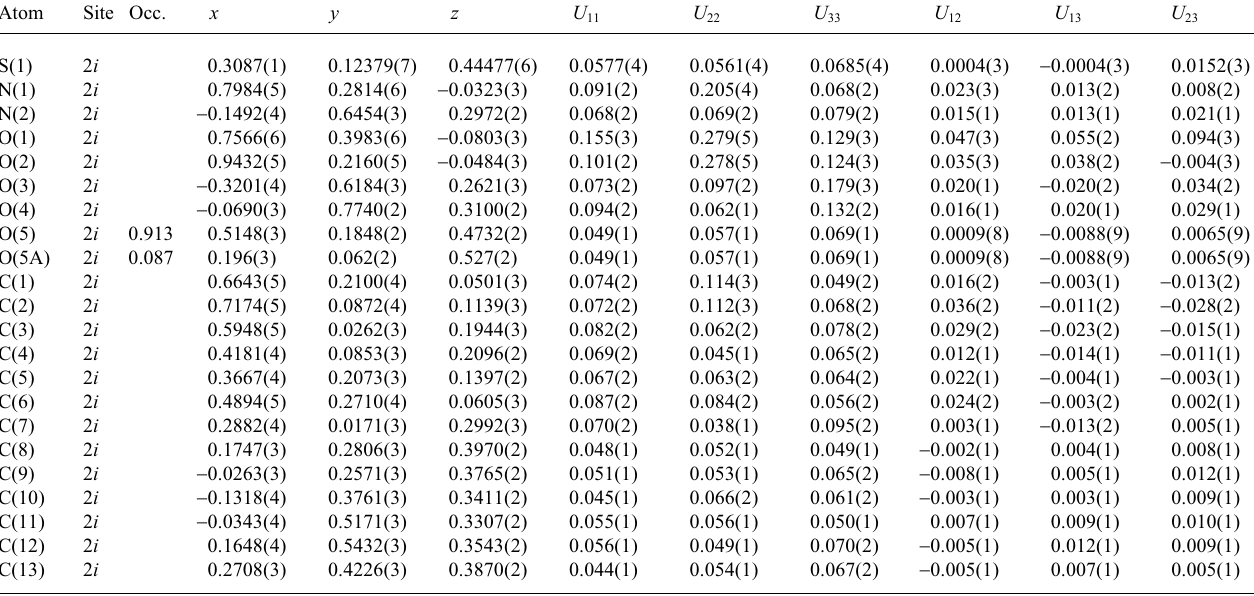
Table 3. Atomic coordinates and displacement parameters (in Å 2 ) . Atom Site